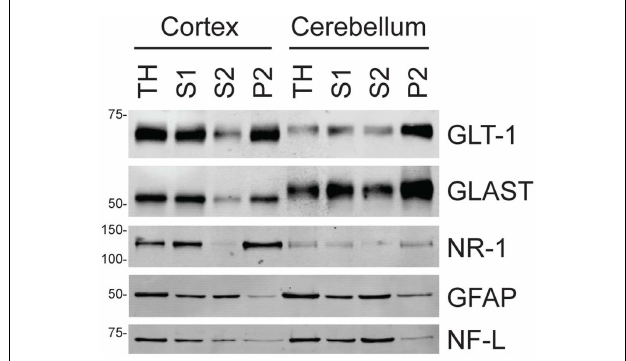
FIGURE 1 |Analyses of neuronal and astroglial proteins in tissue homogenate (TH) and various subcellular fractions as described in Section “Materials and Methods .”To ensure that signal was in the linear range, 3 µ g of protein from each fraction were used for the analyses of GLT-1 or GLAST and 10 µ g of protein were for the analyses of the other proteins (NR1 subunit of the NMDA receptor, NR1; GFAP, and NF-L).The western blots shown are all from one animal; these analyses have been reproduced in three additional animals (see Table 1 for data